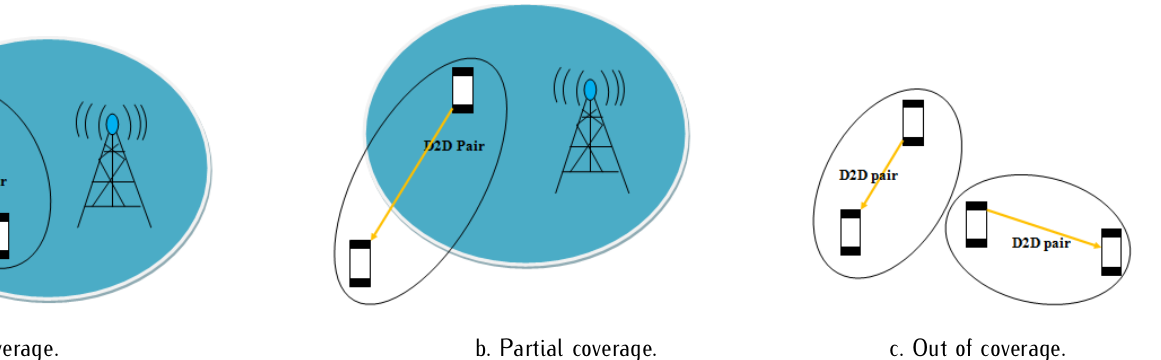
Figure 5. D2D communication